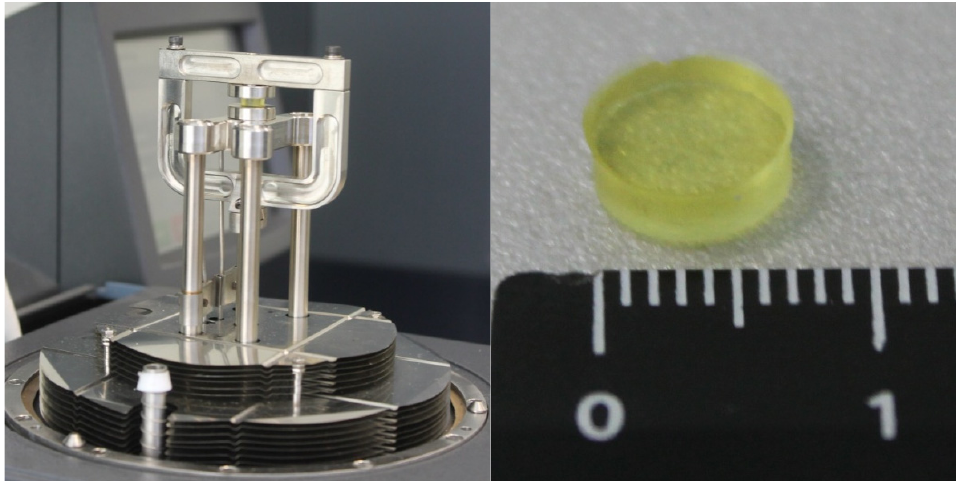
Figure 7. Cylindrical shape specimen and tooling for its thermal cycling tests.